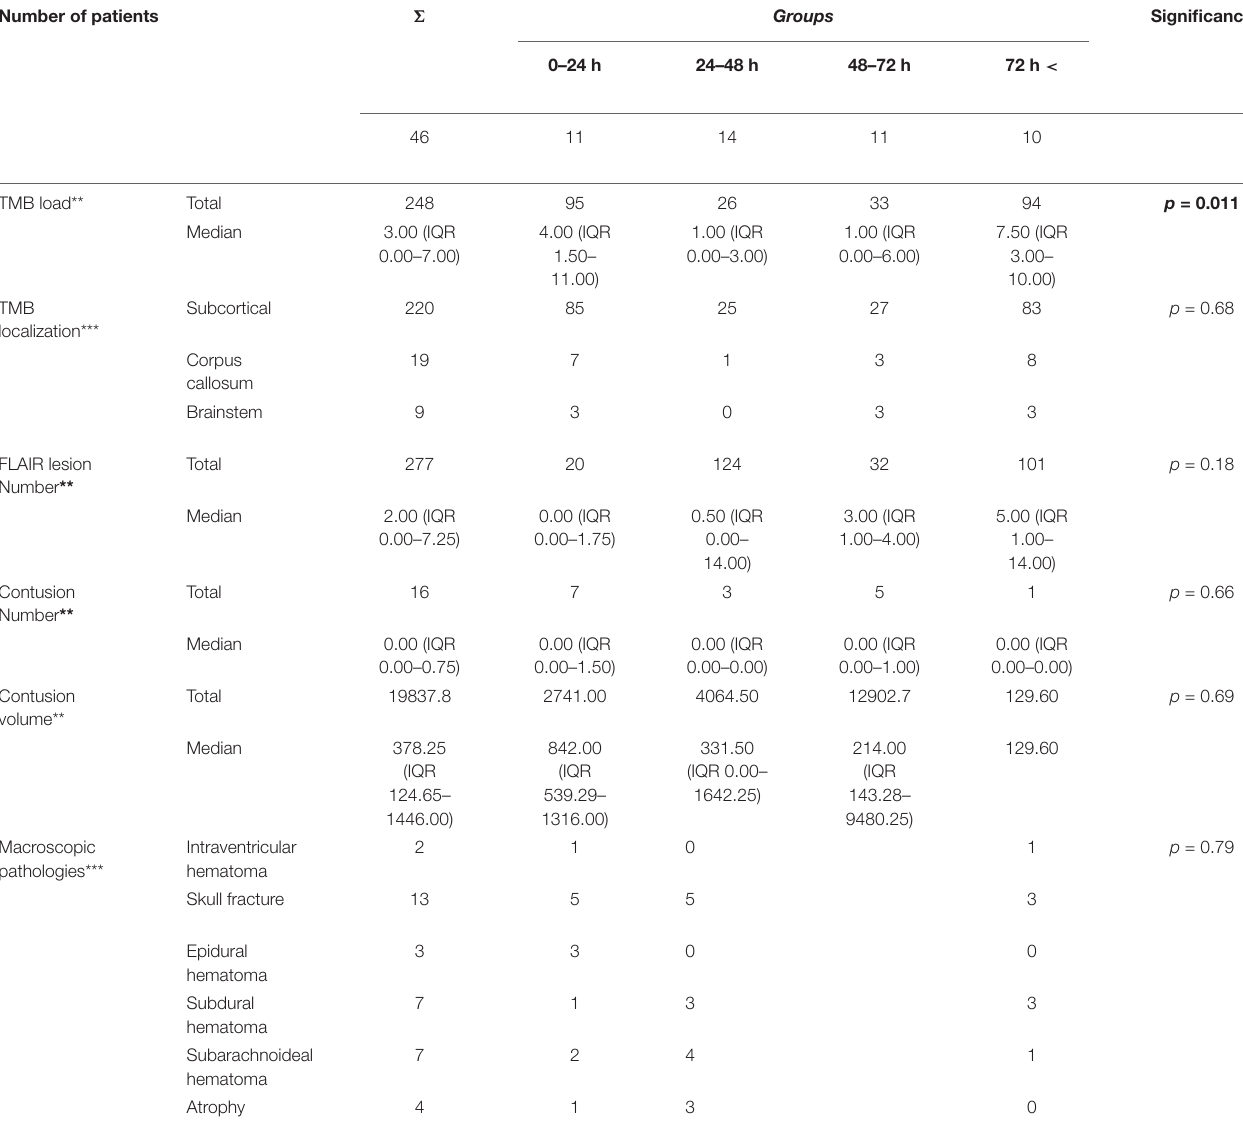
TABLE 3 | Traumatic microbleeds count and localization, macroscopic pathologies, FLAIR lesion counts, contusion number, and volume and the level of significance of differences between groups. Number of patients